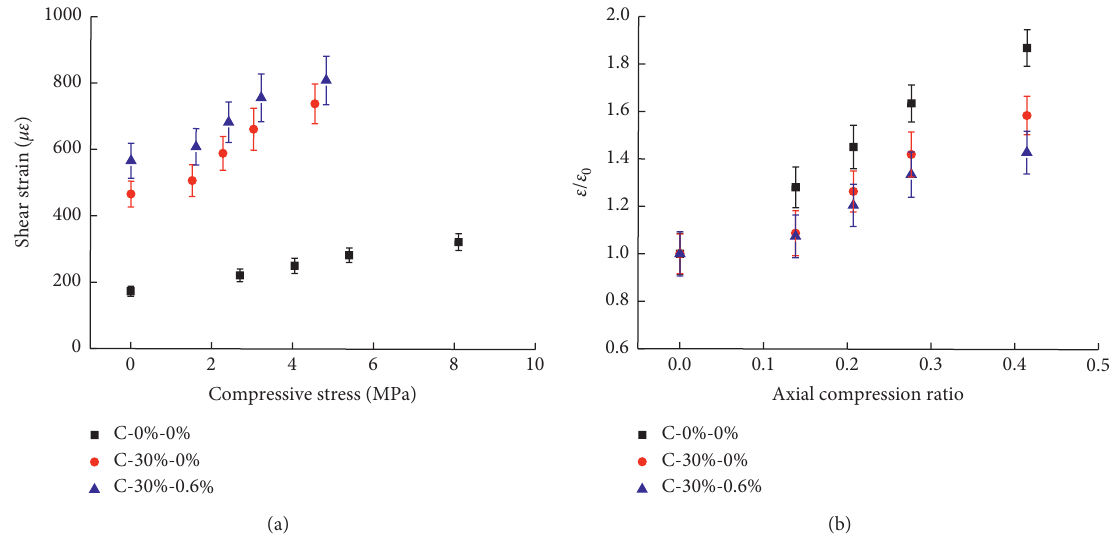
Figure 11: The relationship between the axial compressive stress and shear strain of rubber fiber concrete. (a) Axial compressive stress and shear strain. (b) Axial compression ratio and shear strain variation